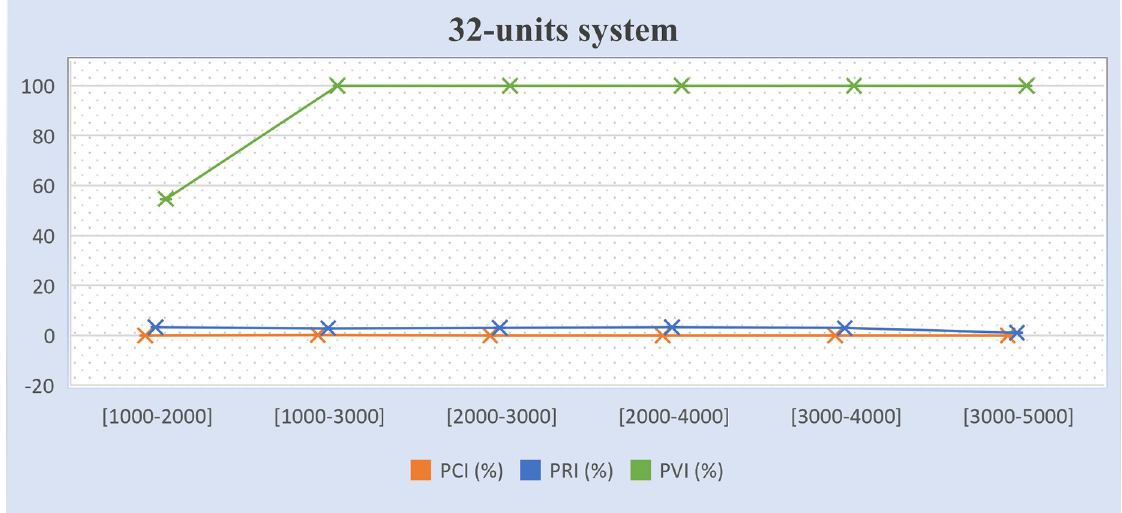
Fig 4. Percentage of improvement in cost, reliability, & violation for GMS model IV with 32-units system.